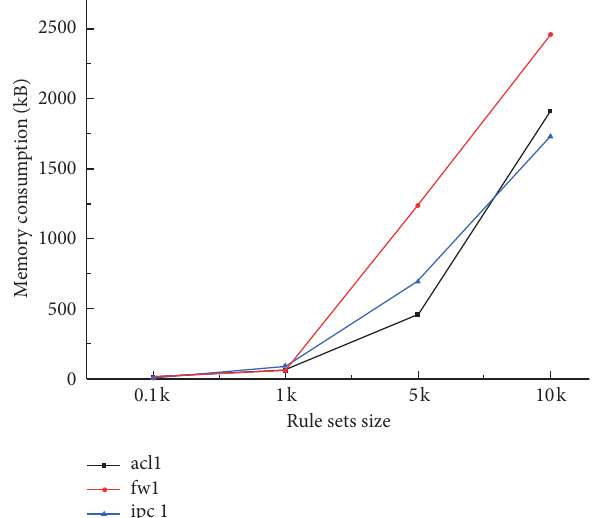
Figure 2: Memory consumption of the PCIU algorithm for different rule sets.